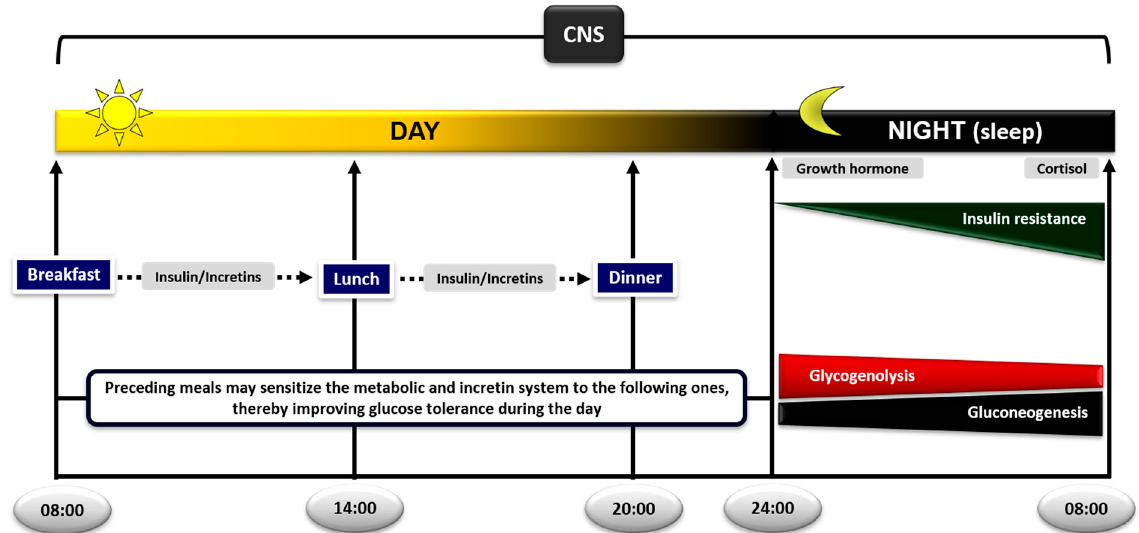
Figure 1. Diurnal regulation of glucose metabolism in the postprandial and postabsorptive state. The sequence of meals plays an important role in postprandial glycemic responses; preceding meals sensitize the metabolic and incretin system to the following ones, thereby improving glucose tolerance during the day. During sleep at night, the gradual development of insulin resistance, due to growth hormone and cortisol surges, ensures that blood glucose levels will be maintained within normal levels until awakening, by switching from glucose to nonesterified fatty acid (NEFA) oxidation in skeletal muscle. The increase in lipolysis and supply of NEFA to the liver and kidneys will also ensure stimulation of gluconeogenesis and glucose production (CNS: central nervous system).